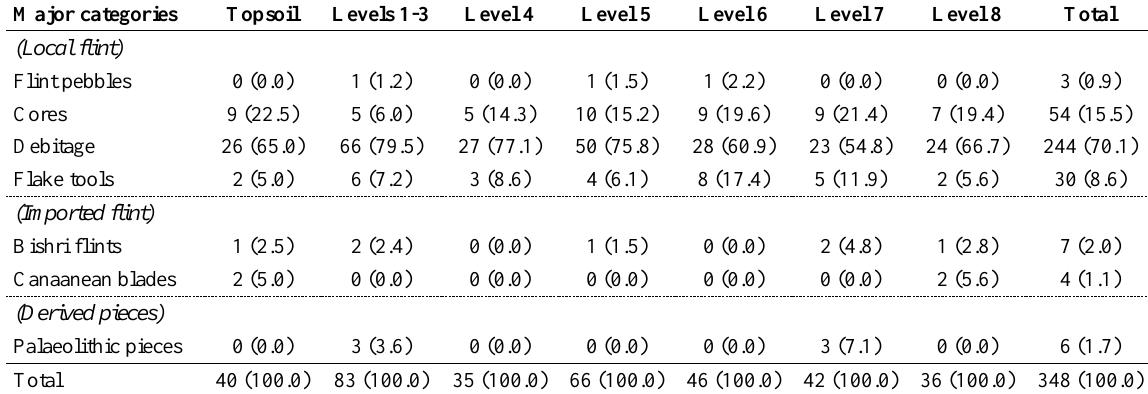
Table 1. The flint collection from Square 2 of Tell Ghanem al-Ali.